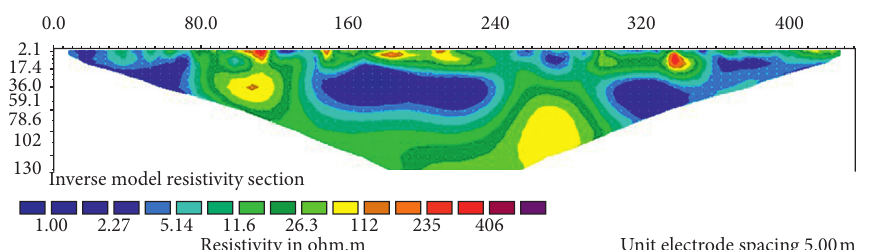
Figure 5: WA-11 resistivity inversion map.